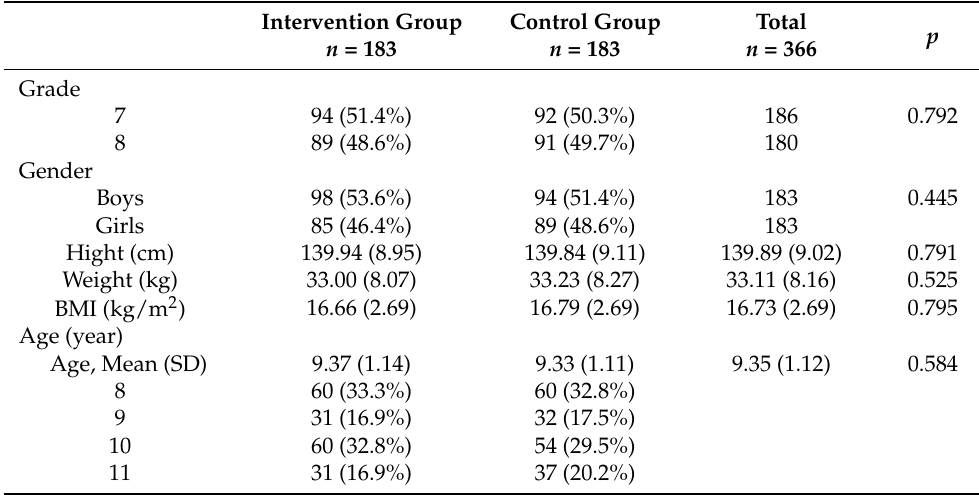
Table 3. Participant